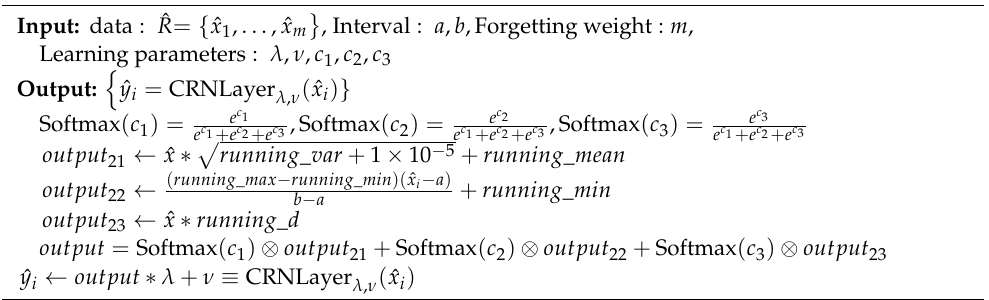
Algorithm 2: Pseudocode for Combined renormalized